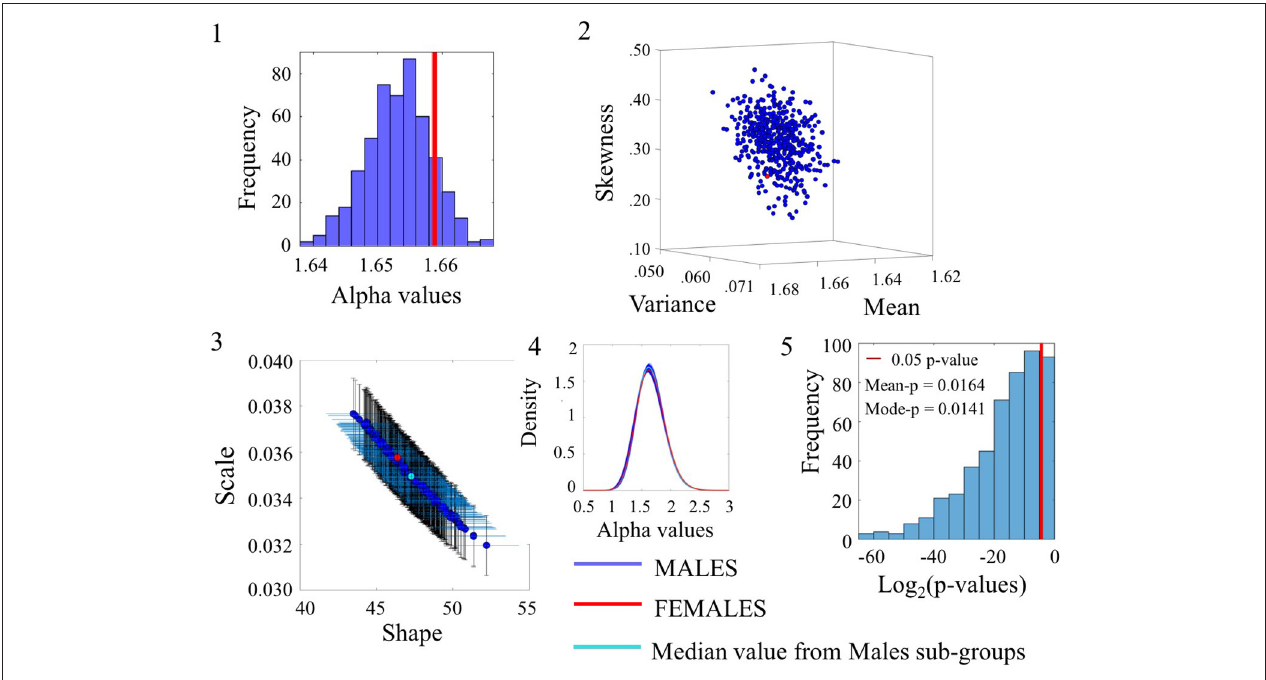
FIGURE 7 | Comparison between Female and Male groups for the Angular Speed (SR0 groups). Figure format similar to Figures 4 – 6